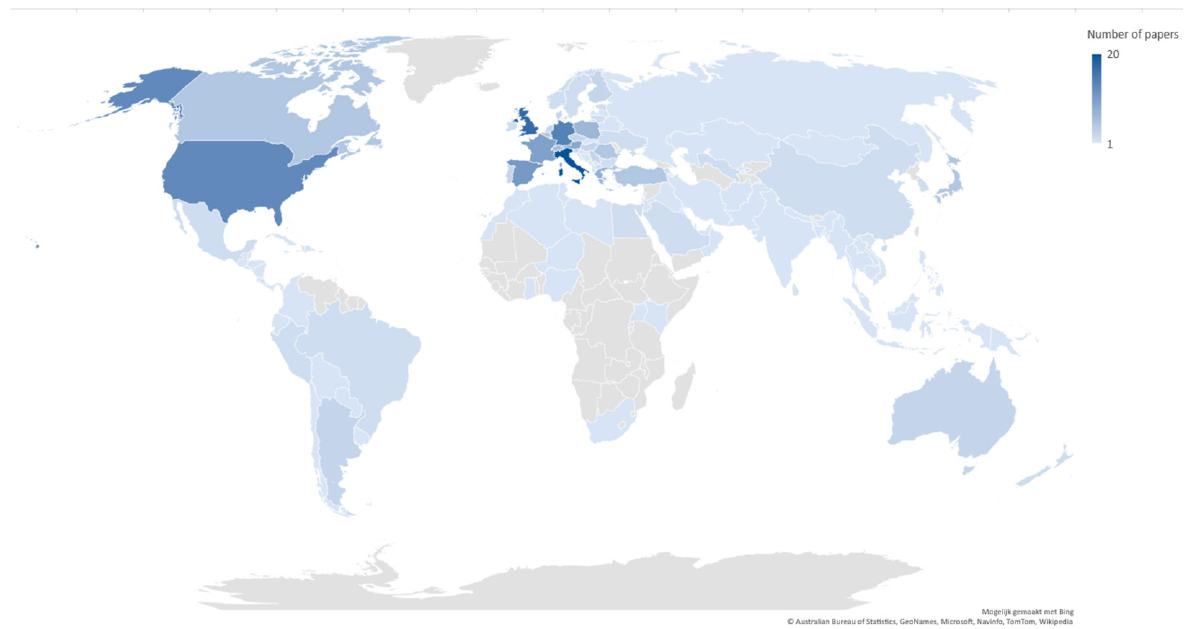
Figure 2. Countries reported on in the included articles (including articles reporting on multiple countries), color-graded according to the number of included papers (n = 109).